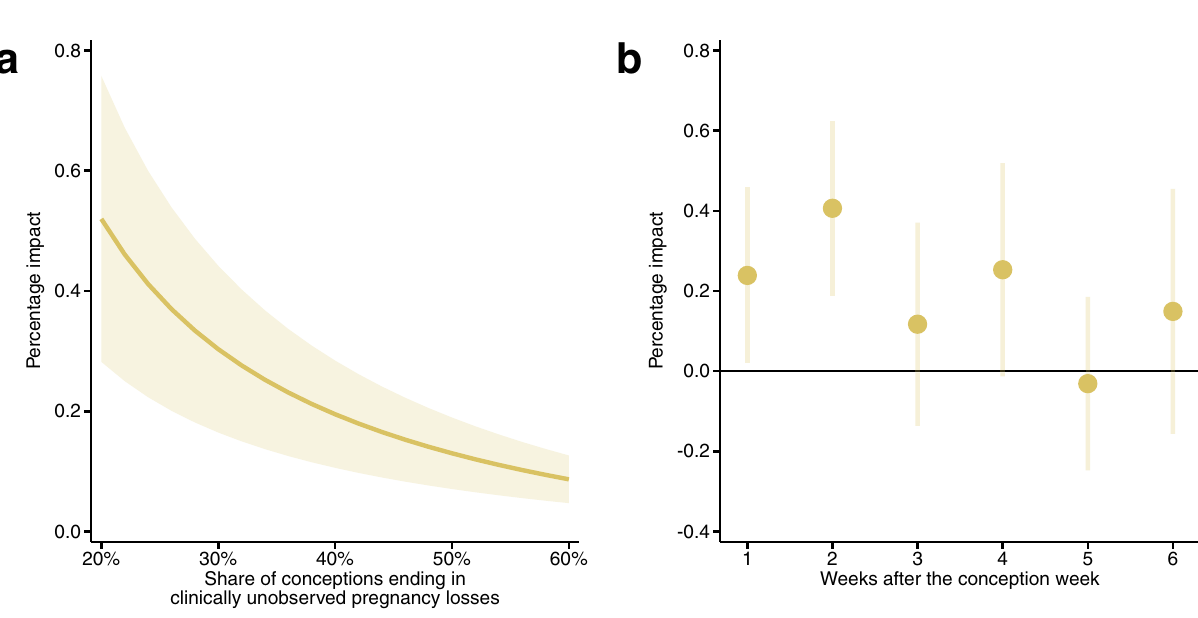
Figure 1. Percentage impact of early pregnancy exposure to a day with a mean temperature above 25 °C on the clinically unobserved pregnancy loss rate. ( a ) The percentage impact of early pregnancy exposure to an additional day with a mean temperature above 25 °C on the clinically unobserved pregnancy loss rate (relative to a day with a mean temperature of 15–20 °C) assuming different values for the share of conceptions that are spontaneously lost before clinical recognition. The early pregnancy period is defined as a six-week-long period starting after the week of conception. ( b ) The percentage impact of exposure to an additional day with a mean temperature above 25 °C on the clinically unobserved pregnancy loss rate by pregnancy week. For this calculation, we assume that 40% of conceptions are lost before clinical recognition. Under this assumption, the baseline weekly rate of clinically unobserved pregnancy losses is 115.2 (per 100,000 women aged 16–44 years). The shaded area and the error bars represent 95% confidence intervals. The estimates come from Eqs. (9) and (13), whereas the percentage impacts are calculated by Eq. (11). The impacts on the clinically unobserved pregnancy loss rate are inferred from regressions with the clinically observed conception rate as the outcome variable. The clinically observed conception rate is calculated using conceptions that end in clinically observed pregnancy outcomes, and it is defined as the number of conceptions per week per 100,000 women aged 16–44 years. The model has county-by-year fixed effects, region-by-calendar-week fixed effects, and region-by- calendar-week-specific quadratic time trends. Precipitation, pre-conception weather, and the share of non- working days are controlled for. We weight by the counties’ average female population size (aged 16–44 years) between 1981 and 2015. Standard errors are clustered by county and